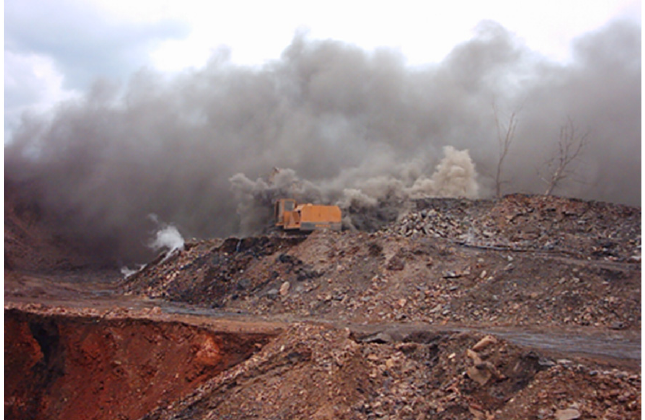
Figure 10. Dust of the atmosphere during earthworks on a burning dump in Zabrze.